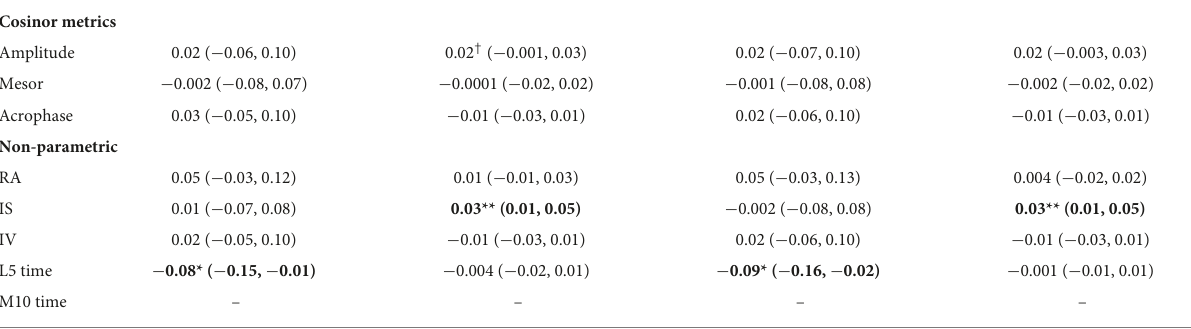
TABLE 6 Associations of circadian metrics with memory, estimated beta (95% CI).